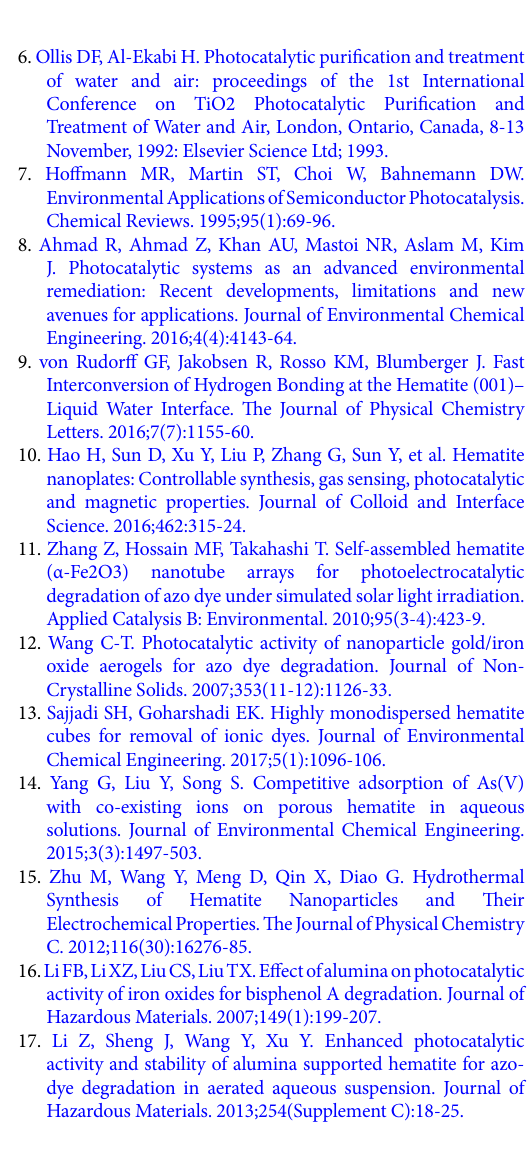
171 Nanochem Res 2(2): 166-171, Summer and Autumn 2017